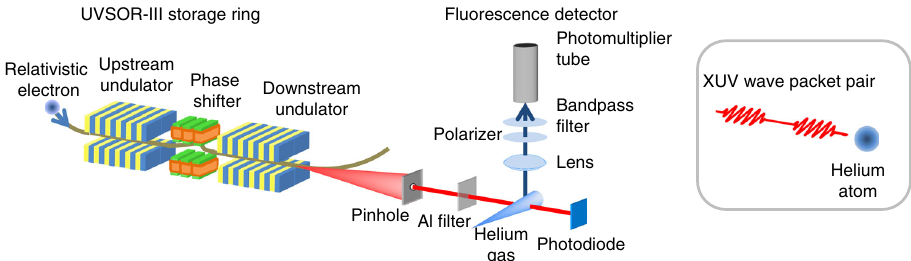
Fig. 1 Schematic layout of the experimental setup. Individual relativistic electrons traversing inside the twin undulators generate a pair of linearly-polarized electromagnetic wave packets. Each of the light wave packets has a duration of ~1.8 fs and consists of 10-cycle oscillations. Some 10 9 of light wave packet pairs with this common waveform, distributing randomly in time, constitute a light pulse (300-ps duration) from the